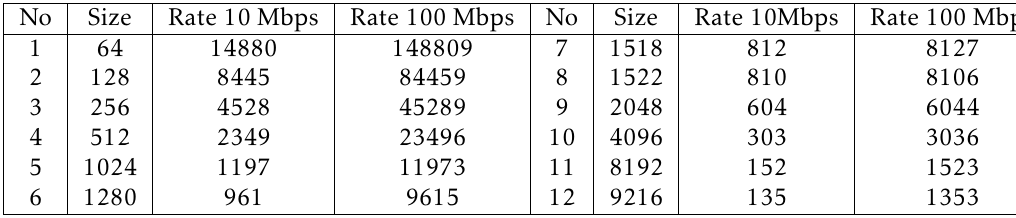
Figure 1. Experimental setup Table 1. Workload Framesize ×